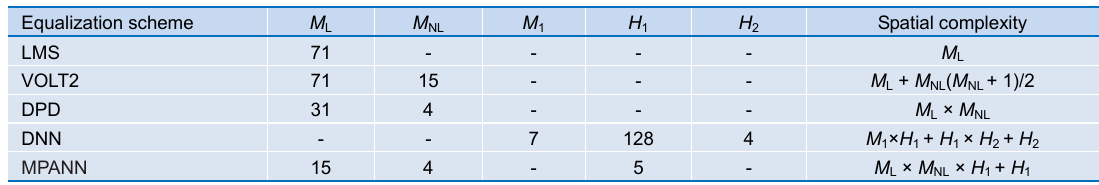
Fig. 7 | ( a ) Q factor performance comparison versus data rate with the equalization schemes of LMS, VOLT2, DPD, DNN and MPANN. ( b ) Spatial complexity comparison among the different equalization schemes. Table 1 | Spatial complexity comparison of the equalization